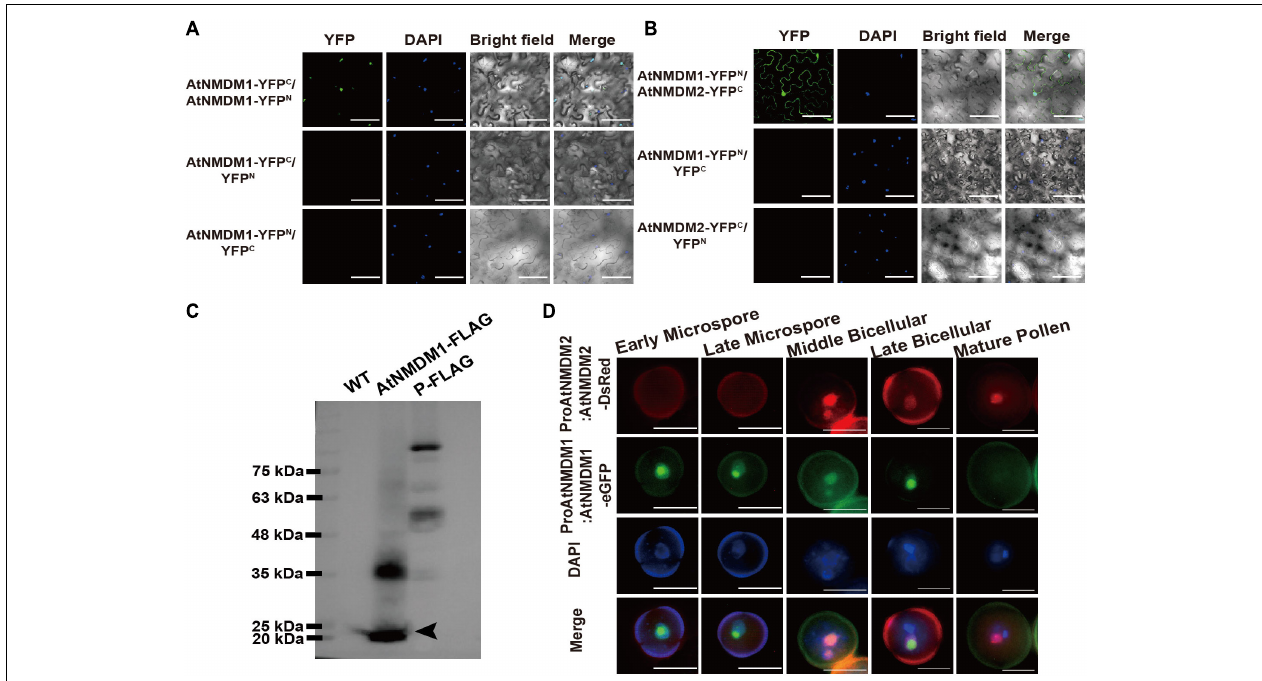
FIGURE 8 | AtNMDM1 interacts with self and AtNMDM2. (A) Examination of homodimers of AtNMDM1 by BiFC assay. (B) BiFC visualization of the interaction between AtNMDM1 with AtNMDM2. Construct pairs showed at the left were cotransformed in the leaves of N. benthamiana by agroinfiltration. Nuclei are indicated by DAPI staining. Yellow fluorescent protein (YFP) signals were detected and imaged by confocal microscopy. Left panels, YFP signal images. Middle panels, DAPI fluorescence, and bright-field images. Right panels, merged DAPI fluorescence images with YFP signals and bright-field images. These experiments were repeated at least three times with similar results. Bars in (A,B) = 100 µ m. (C) Western blot of AtNMDM1 protein infused with FLAG tag. Proteins extracted from the young inflorescence were separated by SDS-PAGE. The protein marker is indicated in the left panel. No bands are shown in the panel of the wild type (WT). Transgenic plants containing AtNMDM1 infused protein with FLAG tag accumulated a putative monomeric protein at approximately 20 kDa (black arrow) while a putative ∼ 40 kDa dimer was also present in the panel of AtNMDM1-FLAG. P-FLAG is a 104-kDa- infused protein. The panel of P-FLAG acts as the positive control. (D) AtNMDM1 colocalizes with AtNMDM2 in pollen nuclei. AtNMDM1-eGFP fusion protein was coexpressed with AtNMDM2-DsRed in the pollen. Fluorescence signals were observed by fluorescence microscopy. From top to bottom, representative pollen grains show DsRed fluorescence (top, red), eGFP fluorescence (next to top, green), DAPI fluorescence (middle, blue), and the three above mentioned fluorescences merged (bottom) at early microspore, late microspore, middle bicellular, late bicellular, and mature pollen grain stages. Bar = 10 µ m.